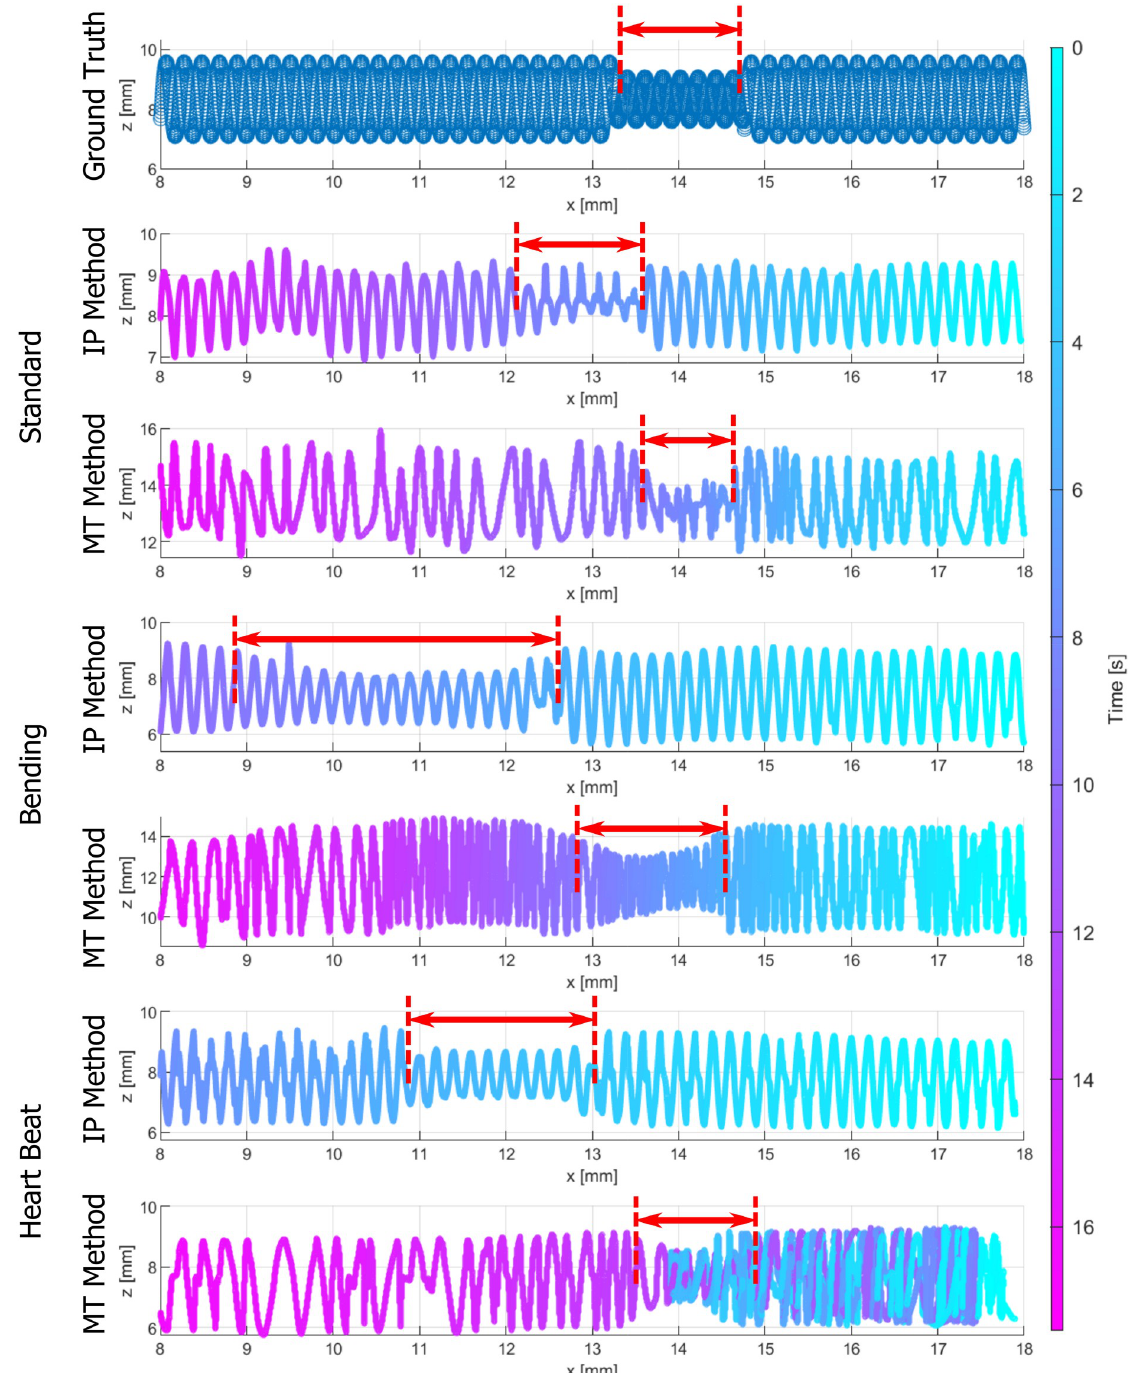
Fig 8. Reconstructed volumes for all motion profiles w.r.t. the ground-truth volume (top) for the cropped MPI FoV. The distances x = 18 and x = 8 mm correspond to the time points t M1 and t M2 . The IP and MT volume reconstructions are labeled (left). The phantom boundary points are colored w.r.t. the time color map (right). The stenosis lengths are depicted with red arrows.